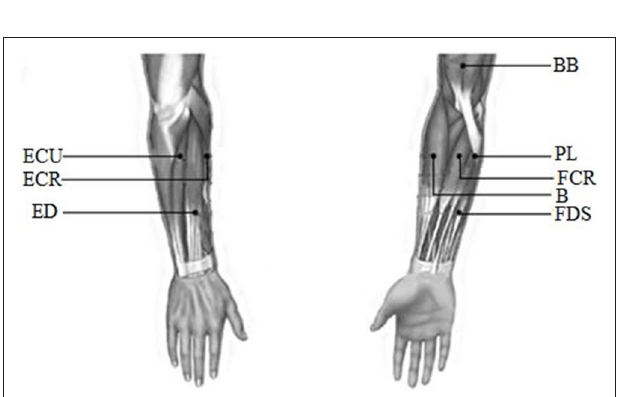
FIGURE 2 | The diagram of the electrode